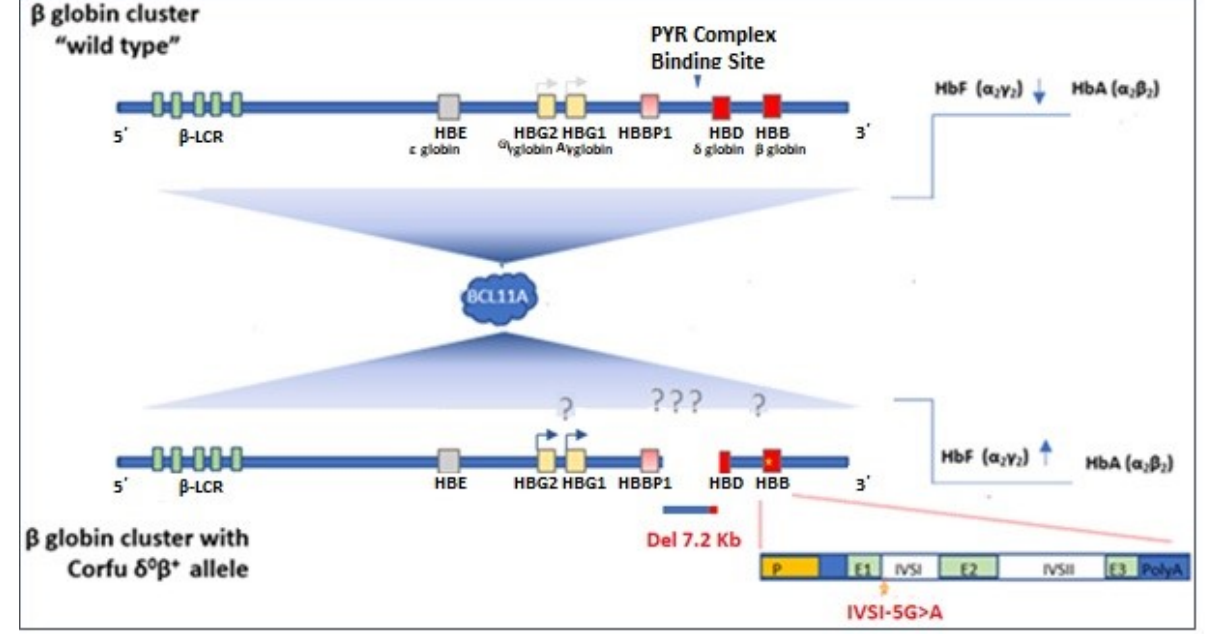
Figure 3. Schematic illustration of β -globin clusters (wild type and Corfu δ 0 β + ) regarding the possible impact of BCL11A on chromatin reconfiguration and genes regulation. BCL11A has been known to enable HBG1/2 silencing through promoter interactions, although a longer-range interaction (shaded triangle) involving the entire β cluster and a region upstream HBD in specific has also been proposed [19]. In the case of 7,2Kb Corfu deletion, both this functional region and a PYR silencing complex binding site are impaired, and in the presence of the HBB:c.92+5 G>A variant, unexpected HBG1/2 gene expression (blue arrows) leads to raised HbF levels.